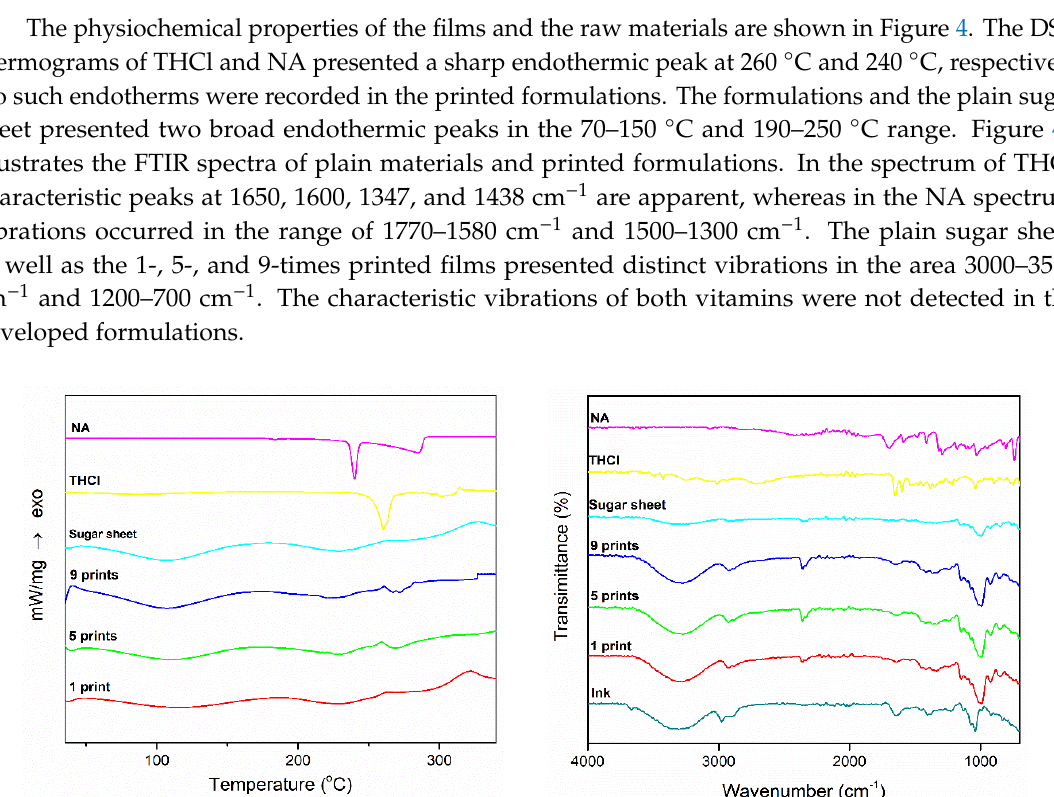
Figure 5. Two-dimensional Fourier transformation infrared correlation spectroscopy (2D-COS-FTIR) technique generated the auto-peaks plot.